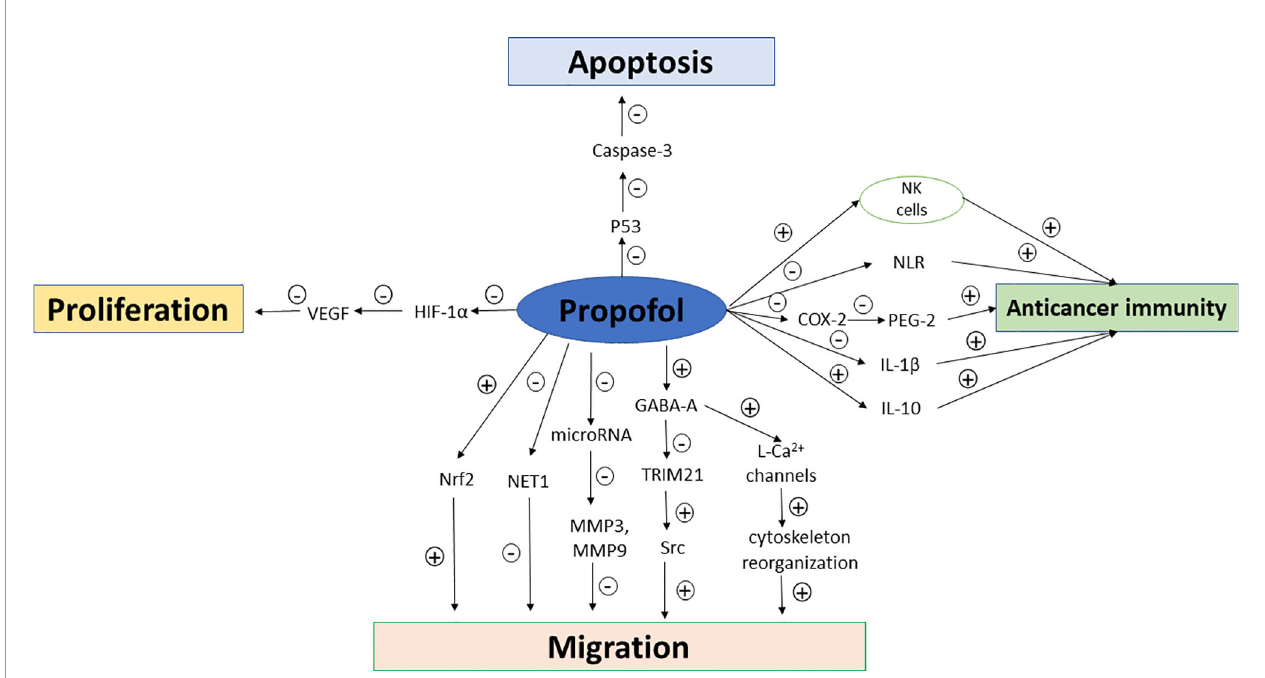
FIGURE 1 | Mechanisms of propofol on anticancer immunity, breast cancer cell proliferation, migration and apoptosis. NK cells, natural killer cells; NLR, neutrophil – lymphocyte ratio; COX-2, cyclooxygenase-2; VEGF, vascular endothelial growth factor; PEG-2, prostaglandin E2; GABA, gamma aminobutyric acid; MMP, Matrix metalloproteinases; HIF-1 a , hypoxia inducible factor-1 a ; TRIM21, tripartite motif 21; Src, non-receptor tyrosine kinase; Nrf2, nuclear factor E2-related